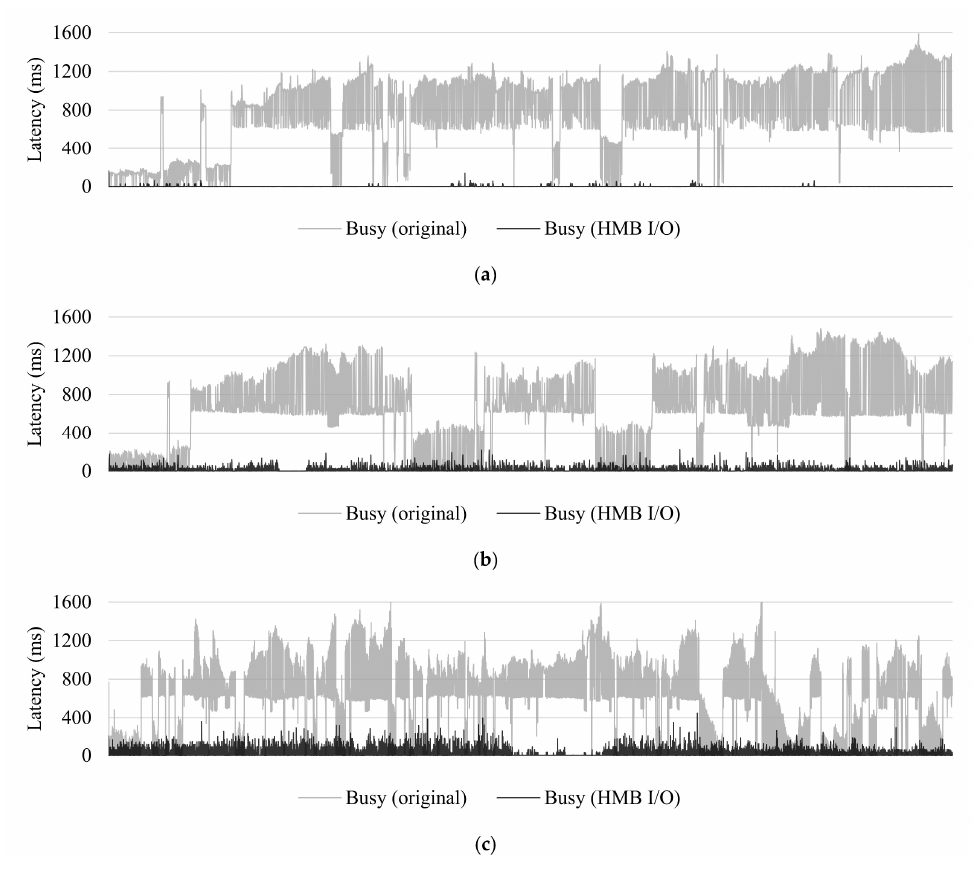
Figure 9. I / O latencies of some workloads. ( a ) Movie; ( b ) Amazon; ( c ) Twitter.